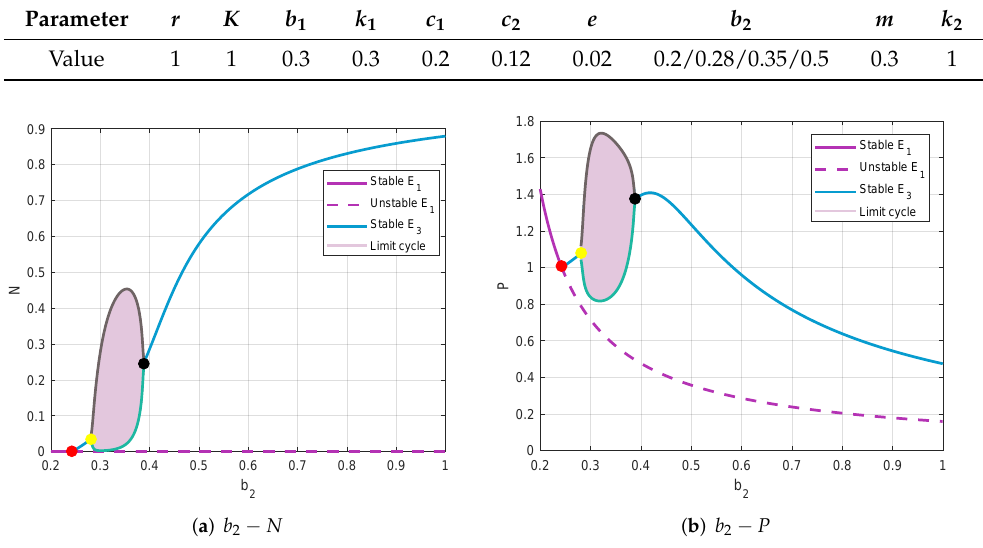
Figure 5. Bifurcation diagram of the system (3) with respect to the cannibalism rate ( b 2 ) with parameter values as in Table 3: ( a ) N state and ( b ) P